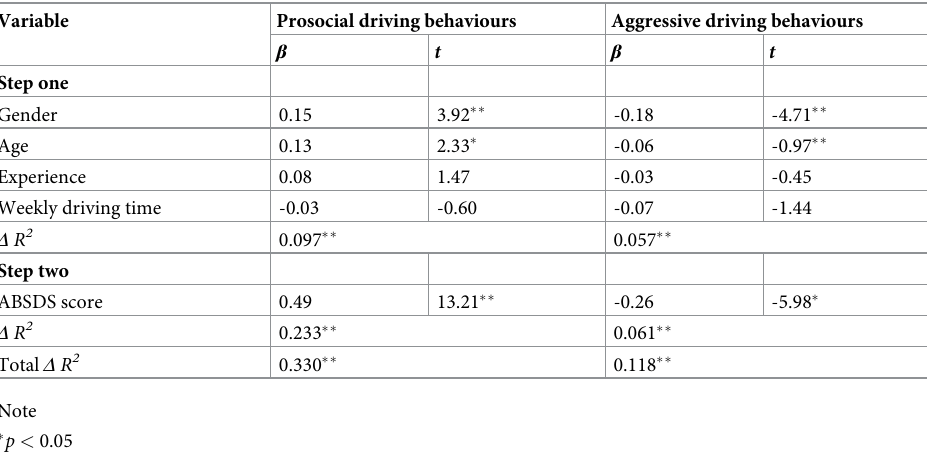
Table 5. Hierarchical regression coefficients for prediction of driving behaviours.